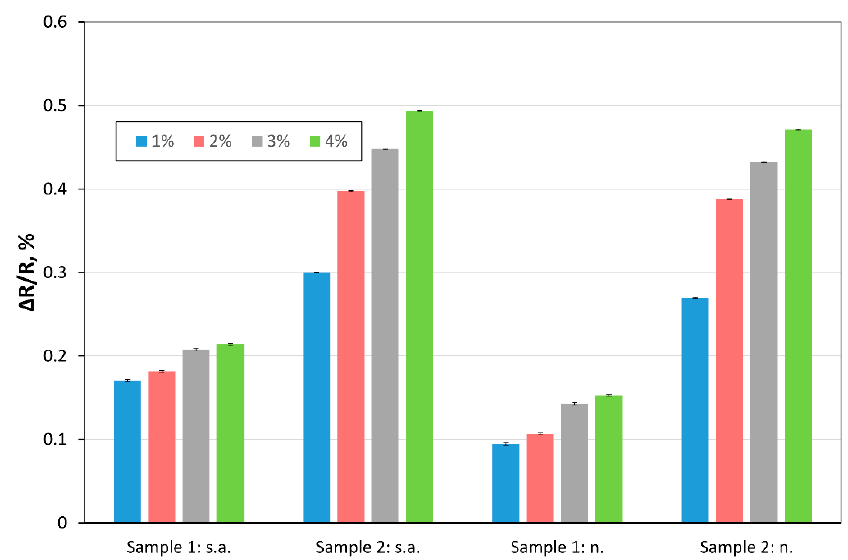
Figure 7. ∆ R calculated for various concentration of hydrogen in synthetic air (“s.a.”) and nitrogen (“n.”), temperature: 150 ◦ C.